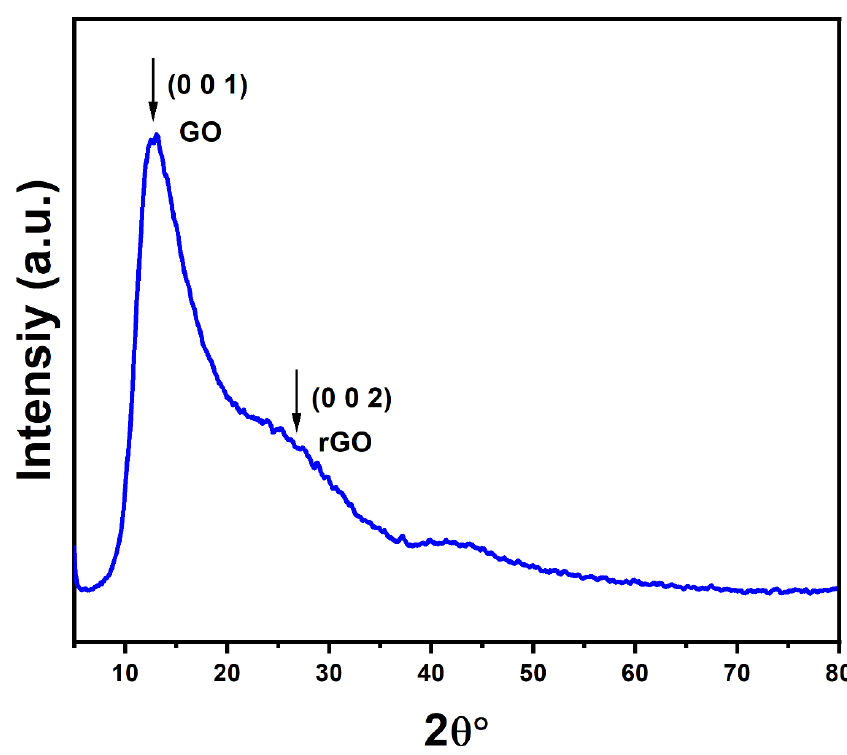
Figure 3. XRD pattern of GO.